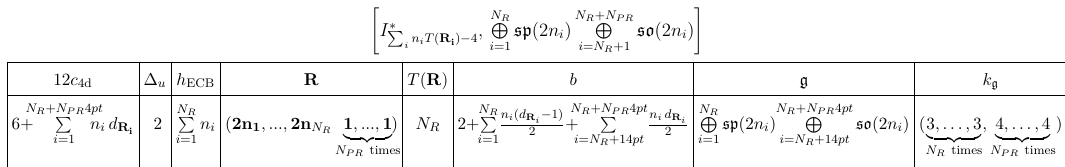
Table 6 . CFT data of N = 2 IR-free theories with U(1) gauge group and n i hypermultiplets of charge q . i